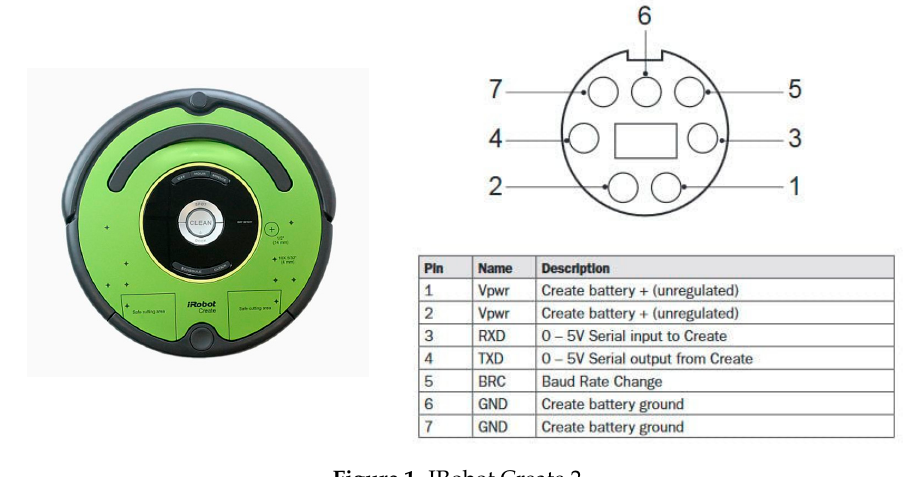
Figure 1. IRobot Create 2.